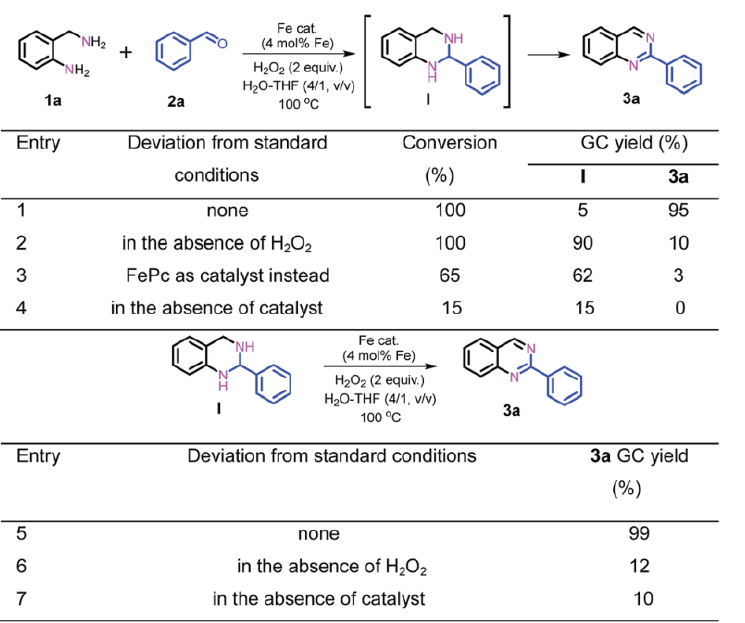
Scheme 1. The role of Fe-Fe 3 C@NC-800 and H 2 O 2 in mechanism exploration. Reprinted with per- mission from Ref. [58]. Copyright 2019, Royal Society of Chemistry.